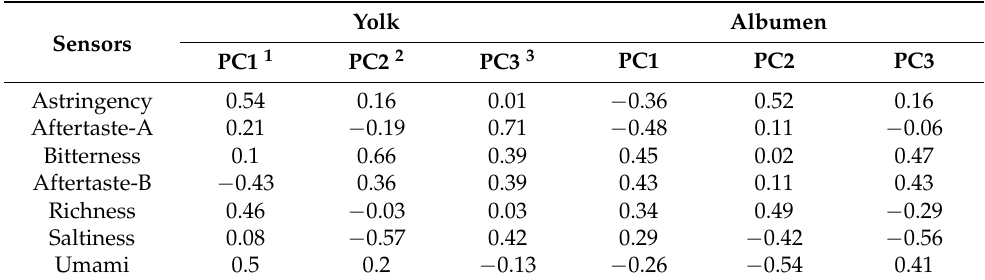
Figure 6. The load coefficient diagrams of electronic tongue by principal component analysis. ( A ) The load coefficient diagrams for yolks. ( B ) The load coefficient diagrams for albumen. Table 6. Electronic tongue load coefficients of egg yolks and albumen by principal component analysis (PCA).